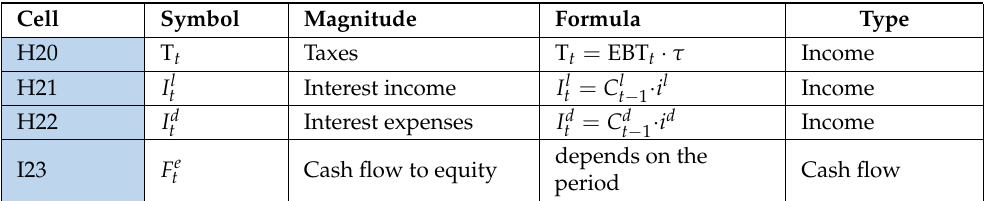
Table 6. Cells whose values are calculated via suitable formulas (blue